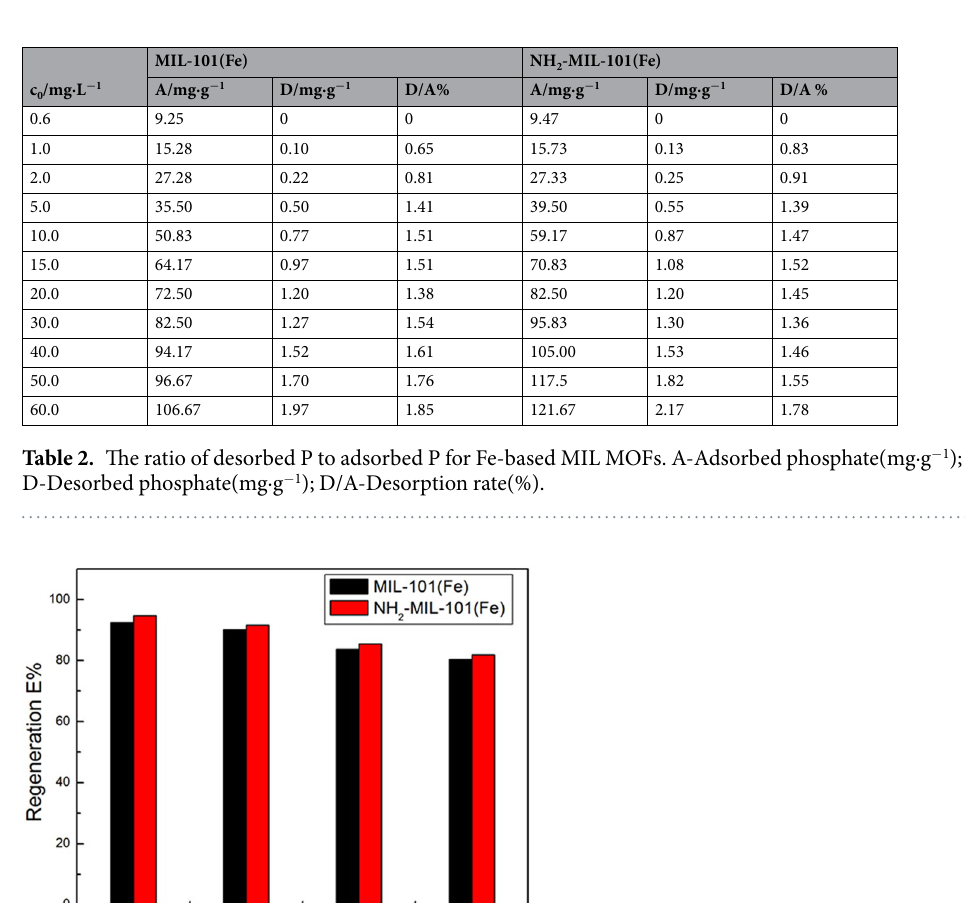
Table 1. Model constants for phosphate adsorption on MIL-101 and NH 2 -MIL-101 from real eutrophic water samples, derived from the pseudo-second-order equation.